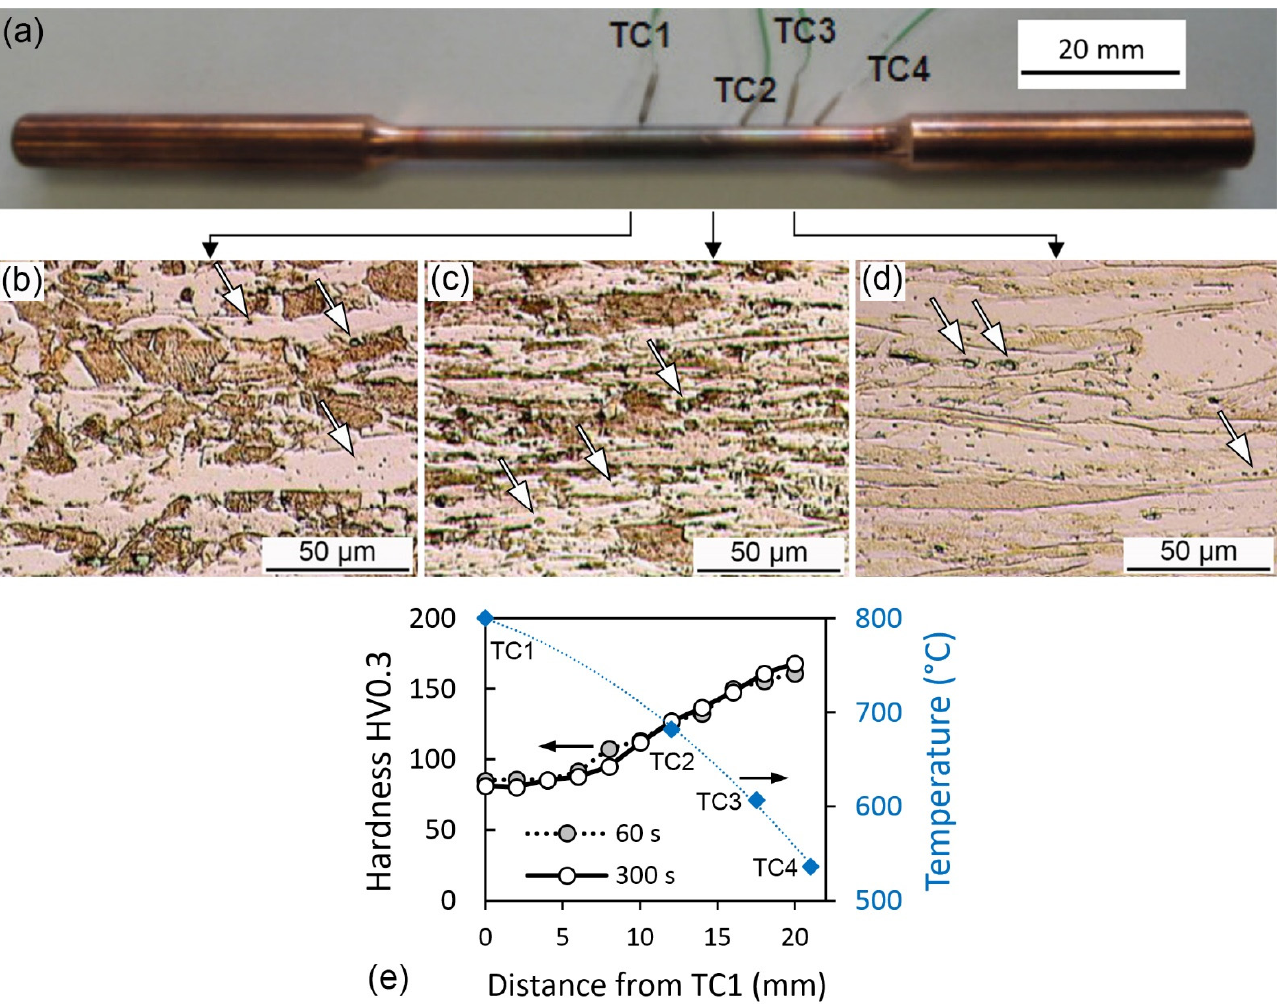
Figure 1. Test specimen with thermocouples ( a ) and grain structure ( b – d ) related to the gradient of the temperature ( e ) during annealing 800 °C/60 s by electric current in the Gleeble machine; microhardness values ( e ) correspond to annealing for 60 and 300 s.